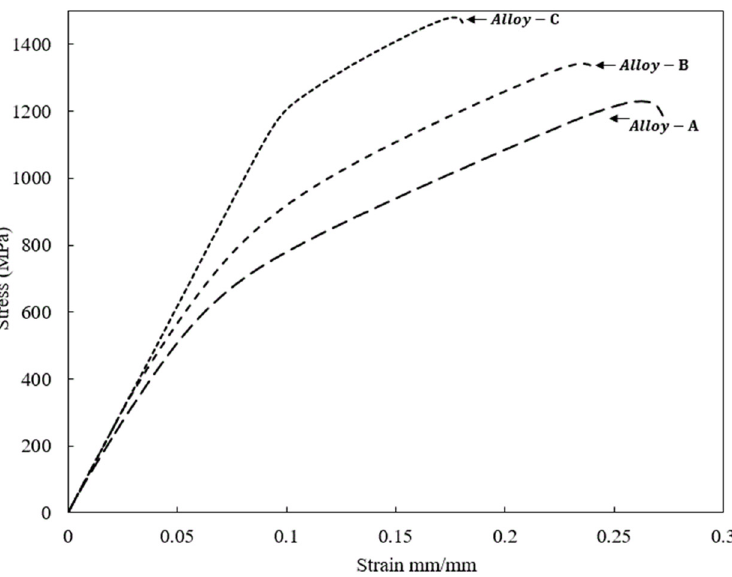
Figure 4. Compressive stress–strain curves of the experimental alloys fabricated by high-pressure spark plasma sintering (HFIHS) procedure. Table 3. Summary of the mechanical and microstructural characteristics of the experimental alloys fabricated by high-pressure spark plasma sintering (HFIHS)